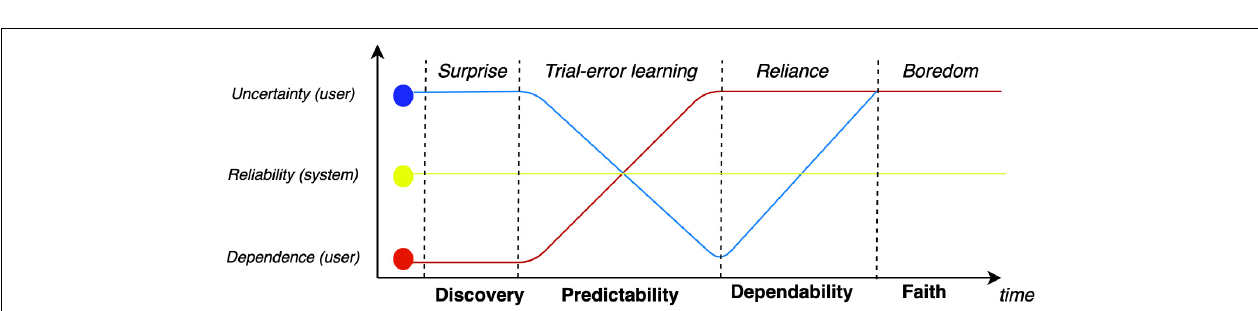
FIGURE 3 | On the left, levels of trust from Dietz and Den Hartog (2006). On the right, cross-plot of (objective) trustworthiness compared to (subjective) trust by Sheridan (1988), Sheridan (2019b). As a pioneer in the study of trust in technology, Sheridan further suggested that (subjective) trust can be cross-plotted against (objective) trustworthiness. This representation engenders four extremes: justified trust or distrust, blind trust (trusted untrustworthy; i.e., misuse) and missed opportunity (untrusted trustworthy; i.e., disuse). The dotted curve represents calibration, which is linear when trust is justified. Poor calibration can lead to loss of safety (due to overconfident misuse), or loss of productivity (due to underconfident disuse).